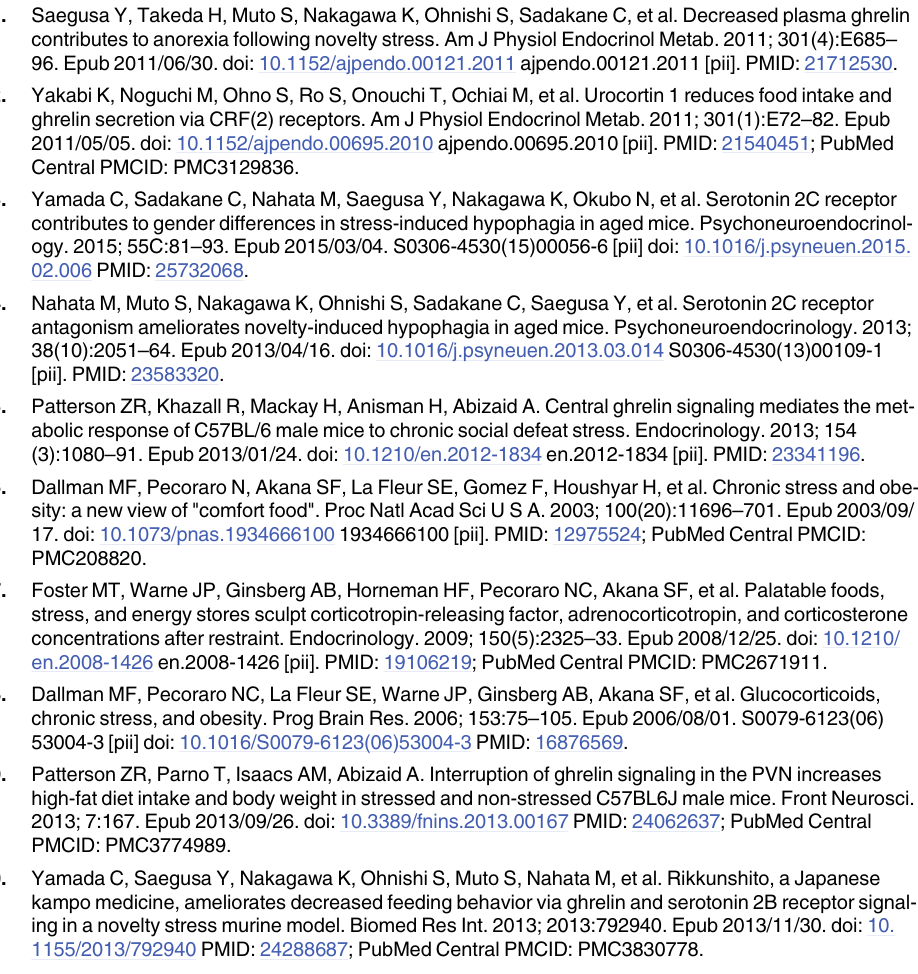
S2 Fig. Changes in orexigenic gene expression after 1 week of isolation. After 1 week of iso- lation, the mice were fasted for 18 h. The gene expression levels are shown in young male mice (A), aged male mice (B), young female mice (C), and aged female mice (D). The data represent the mean ± SEM (n = 4 – 8). (cid:1) , (cid:1)(cid:1) , (cid:1)(cid:1)(cid:1) , p < 0.05, 0.01, 0.001 respectively vs. group-housed